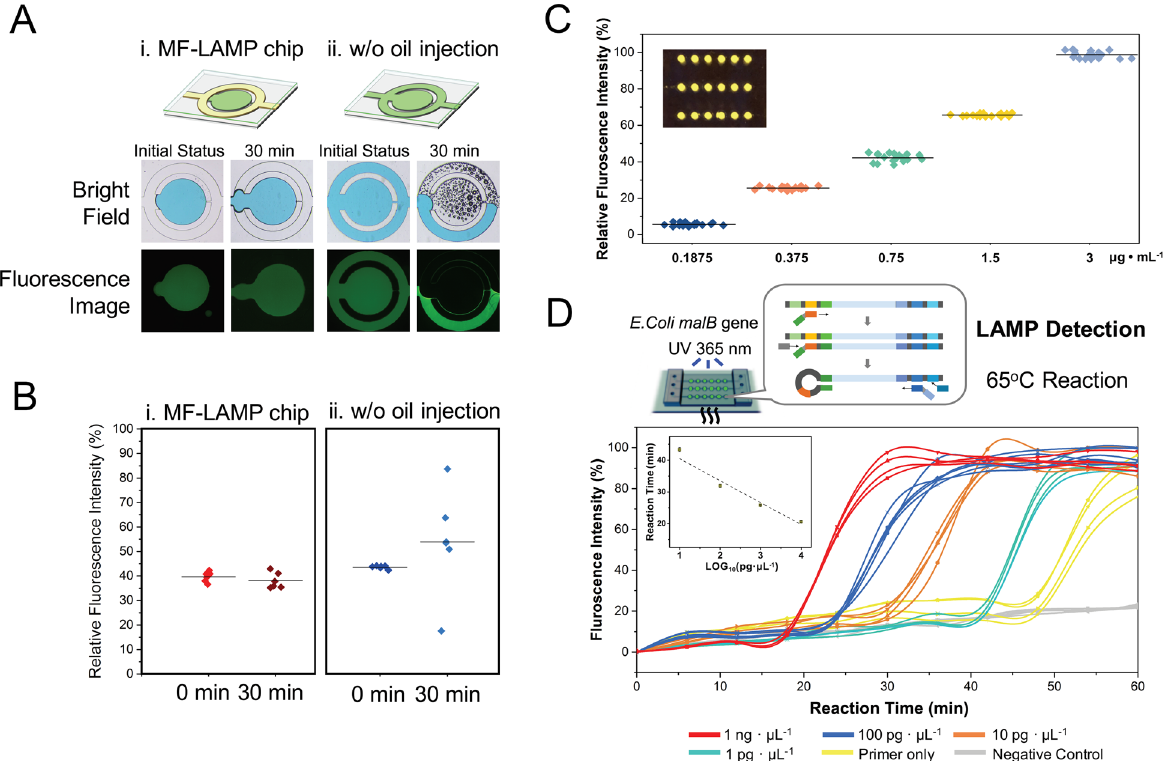
Figure 4. Application of the MF-LAMP chip. ( A ) Different fabrication strategies of MF-LAMP with or without enclosed oil. The colored ink and fluorescence dye allow better observation of the variation of different permeable methods after the heating process. Illustration is visualized by PowerPoint. ( B ) Comparison of each method according to fluorescence variance between the initial status and the after heating status. ( C ) Analysis of the uniformity of the intensity in each reaction chamber with different fluorescence concentrations. ( D ) Amplification curves for detecting different concentrations of E. coli DNA (10 3 , 10 2 , 10, and 1 pg µL −1 ) generated by the processing of the fluorescence images. Illustration of mechanism is visualized by